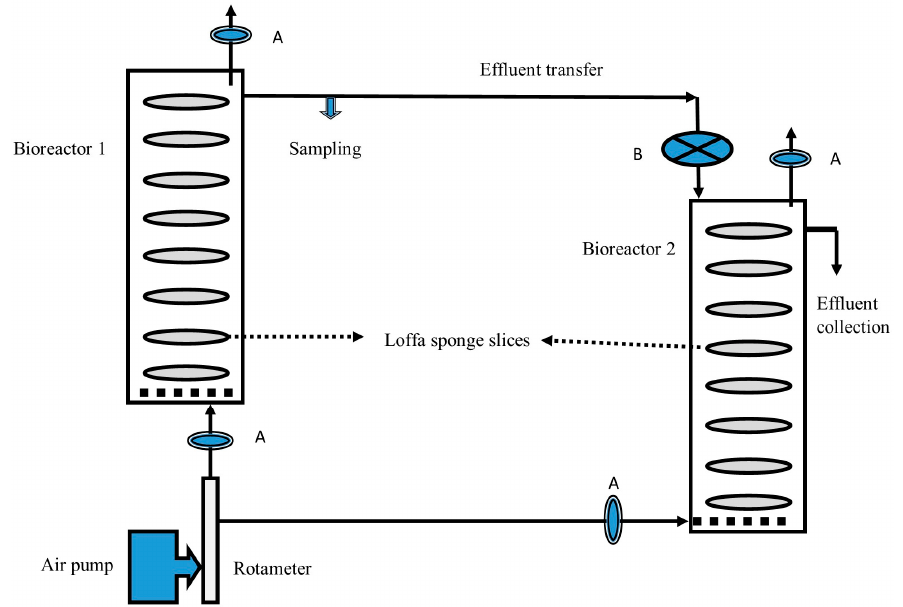
Figure 1. Schematic diagram of the two-stage process for simultaneous cellulase enzyme and citric acid production employing loofa sponge-packed column bioreactors. A: Air filters; B: Glass wool depth filter.